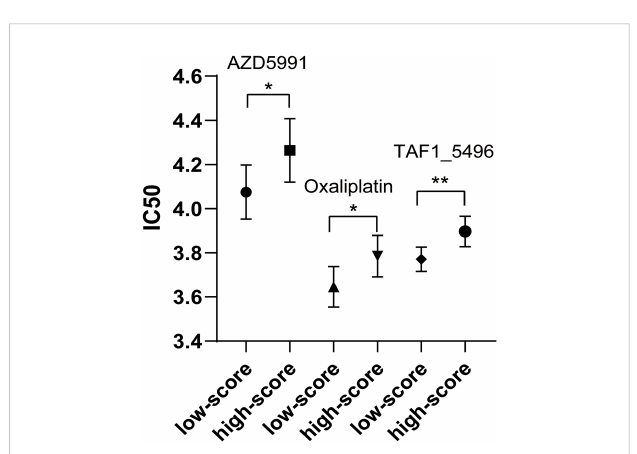
FIGURE 8 Comparison of IC50 of three chemotherapeutic drugs between low- risk group and high-risk group. * P < 0.05. ** P <